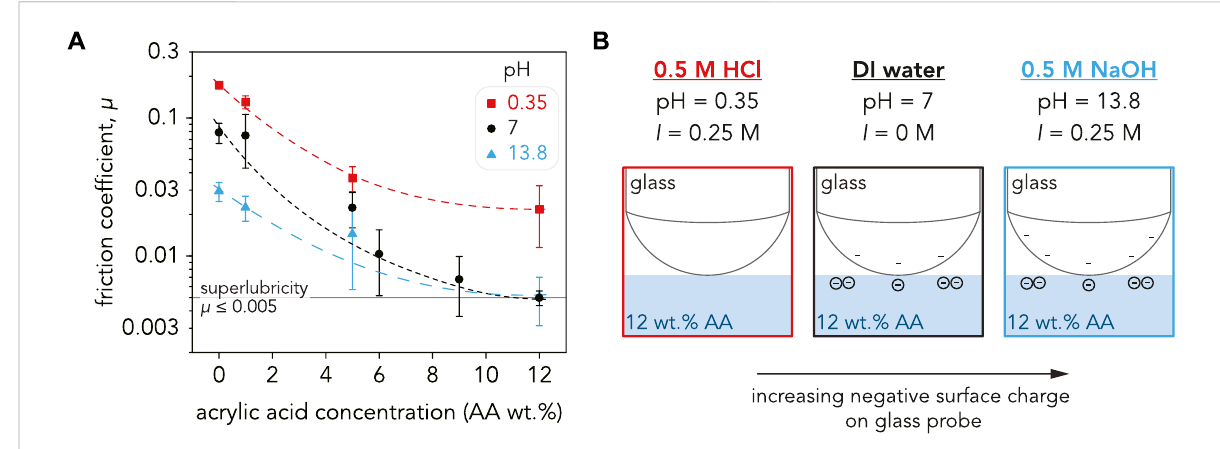
FIGURE 4 (A) Friction coef fi cient, µ , for the P(AAm- co -AA) hydrogels as a function of AA concentration plotted on a semi-log scale. For all pH values, the friction coef fi cient decreased with increasing AA concentration. Friction was the highest at pH = 0.35 (red squares) with 0 wt% AA ( µ = 0.17 ± 0.009) anddecreasedto µ =0.02±0.01 at12 wt%AA.ThehydrogelswithlowAAconcentration(0 – 5 wt%AA)hadthelowest µ inNaOH(bluetriangles),but µ was lower in DI water (black circles) at higher AA concentrations. Superlubricity was achieved for the P(AAm- co -AA)-12 hydrogel in DI water ( µ = 0.005 ± 0.001) and NaOH ( µ = 0.005 ± 0.002). The dashed lines are guidelines and not meant to indicate a fi t. Each data point is an average of three samples ( n = 3) with the error bars as the standard deviation. (B) Schematic depicting the surface charge of the glass probe at pH = 0.35, 7, and 13.8. Since the friction coef fi cient is a systems property and not an intrinsic material property, µ depends on the properties of the countersurface as well as the substrate. The surface charge of glass increases with increasing pH, and the electrostatic repulsion between the carboxylate ions in the P(AAm- co -AA) hydrogels and SiO − ions in the glass probe may be contributing to the lower friction exhibited in DI water and